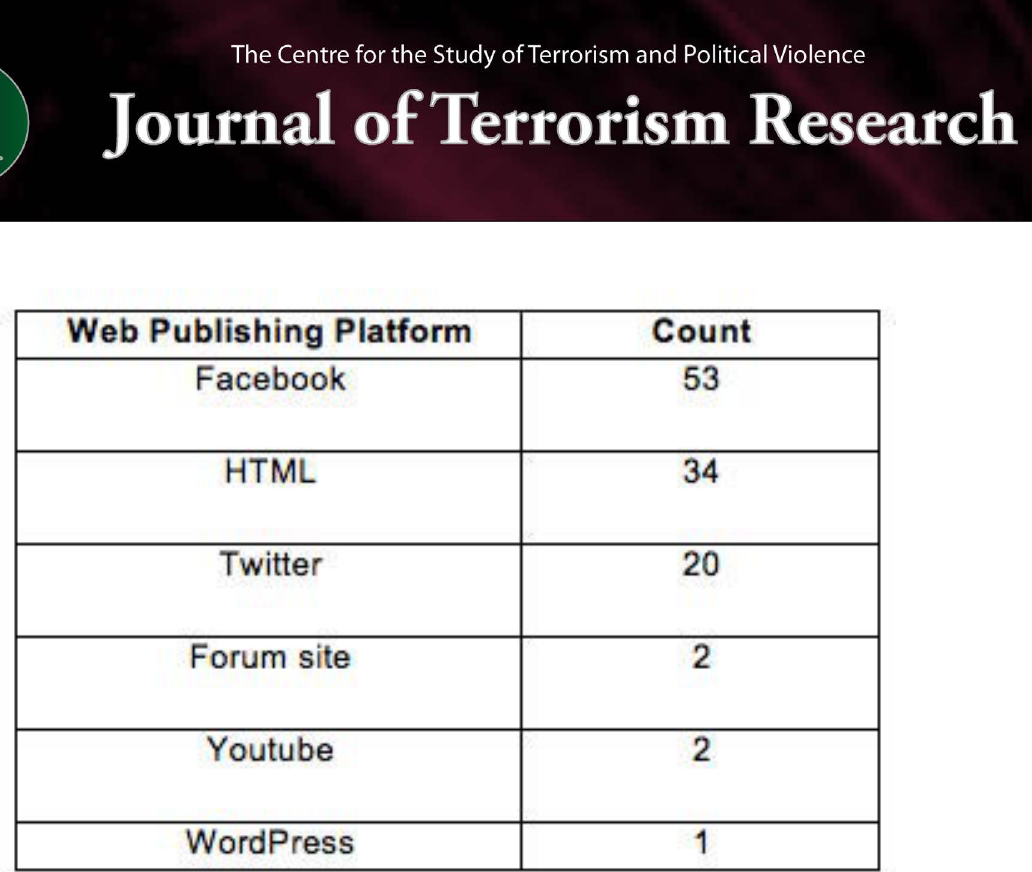
Figure 3: Count of web publishing